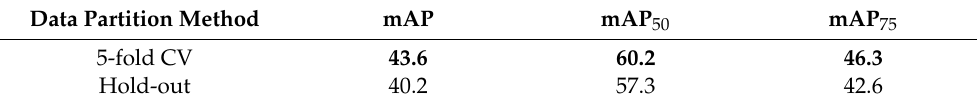
Table 2. Comparison of the object detection accuracy for different data partition methods.